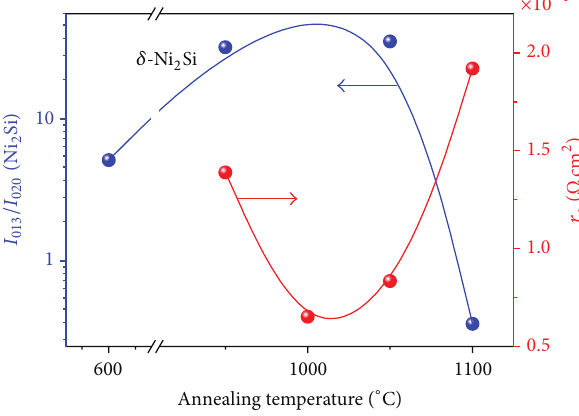
Figure 11: Specific contact resistances ( 𝑟 𝑐 ) of Ni 2 Si/4H- n -SiC ohmic contacts and Ni 2 Si texture ( 𝐼 013 /𝐼 020 ) versus annealing